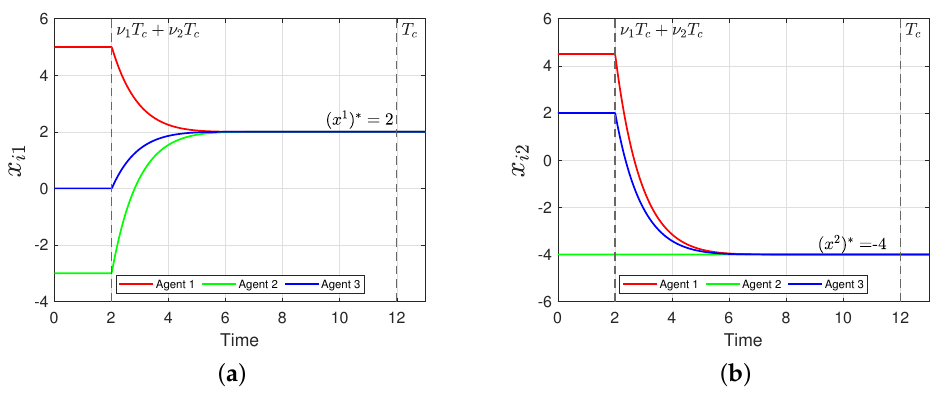
Figure 4. Evolution of the position of the agents in the presence of matched disturbances with respect to time. ( a ) x i 1 ( b ) x i 2 .